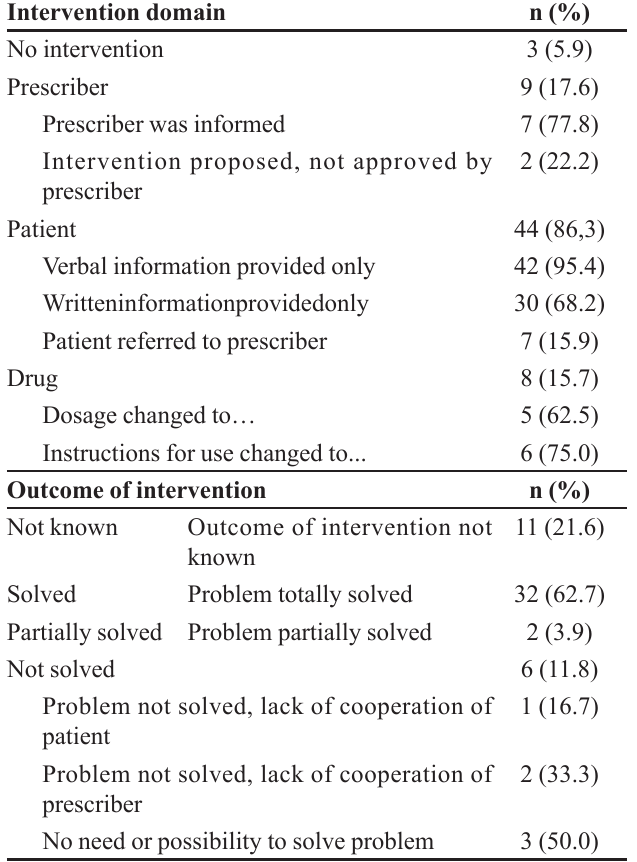
TABLE I - Drug related problems identified during the dispensing process at Campus Pharmacy, Goias, Brazil, 2013 Variables